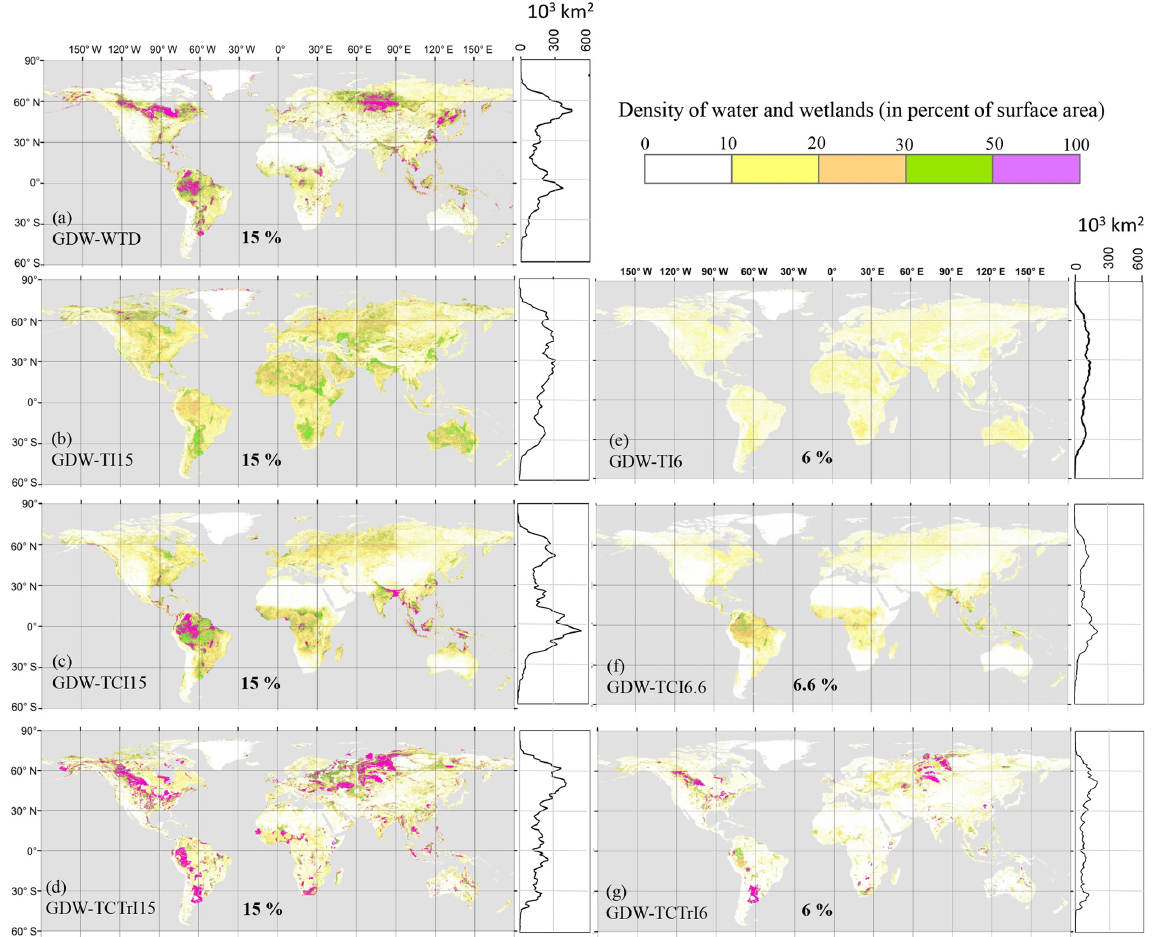
Figure 2. Density of scattered groundwater wetlands based on different approaches (percent area in 3arcmin grid cells). For zonal wetland area distributions (right-hand charts), the area covered by wetlands in each 1 ◦ latitude band is